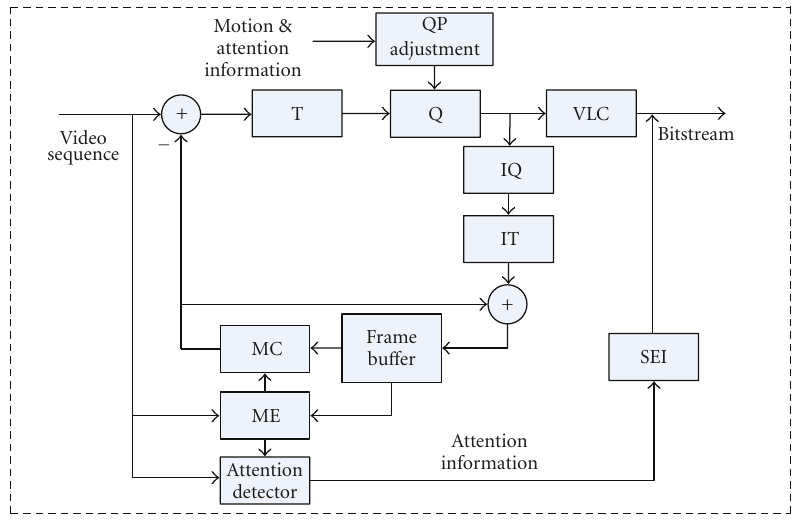
Figure 2: The block diagram of video content generation.